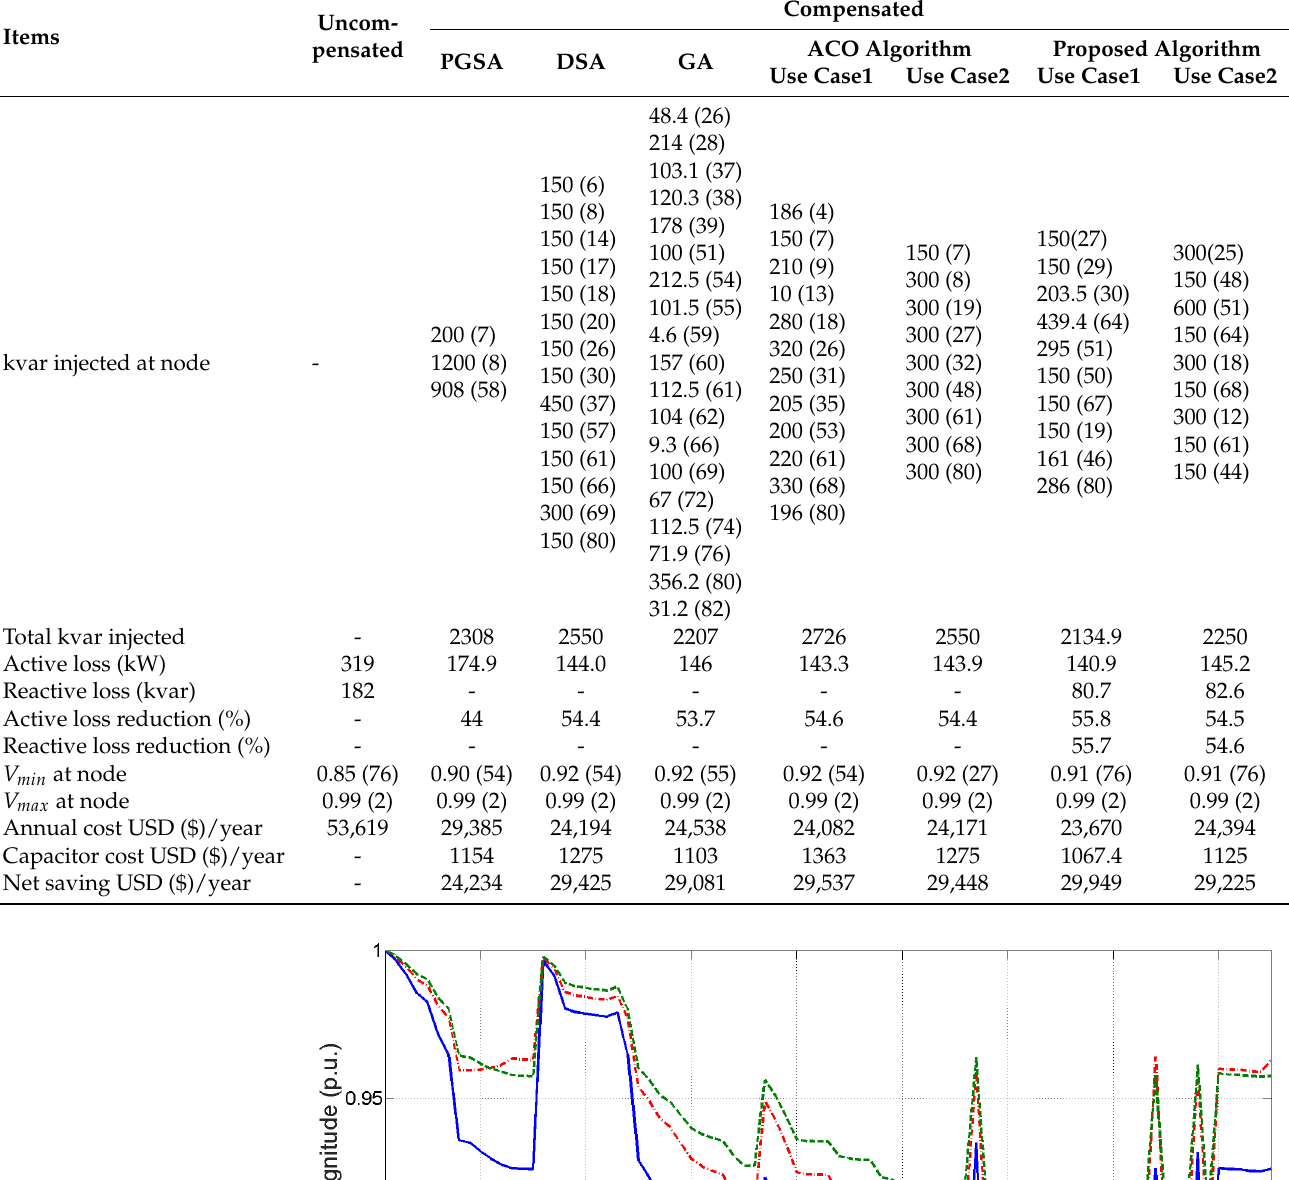
Table 3. Results comparison of N 2 for CS 1 .